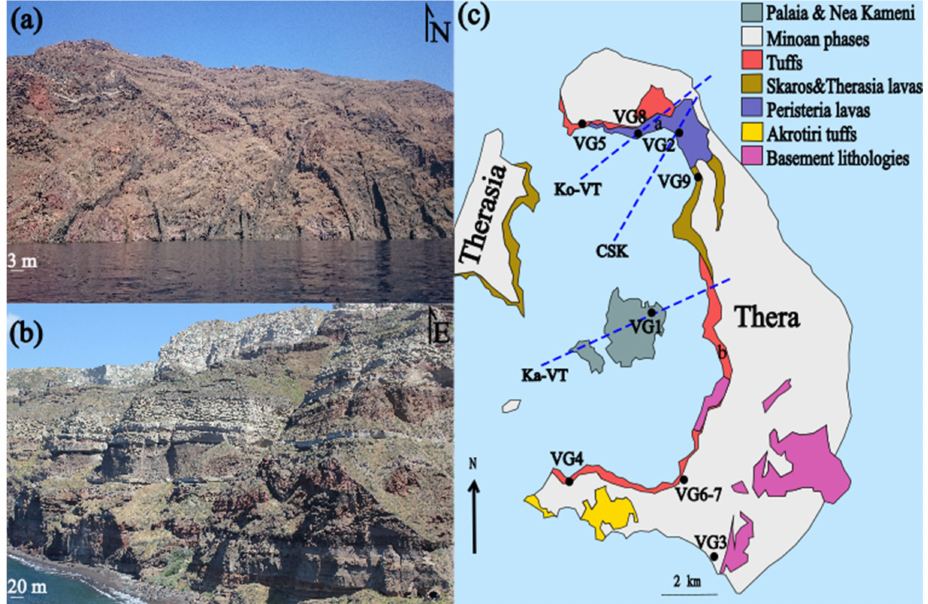
Figure 1. ( a ) Panorama of the northern caldera wall dike swarm showing the heterogeneous and anisotropic crustal segment composed of lava flows and pyroclastic materials. The latter are dissected by 91 dike segments. ( b ) View of Athinios Port with details of the pyroclastic successions derived from the two main eruptive phases, the Minoan and middle pumice layers, which formed the characteristic landforms and erosional surfaces; caldera walls are ~400 m high and extend underneath the water level, to a depth of 390 m (photo courtesy: Agust Gudmundsson). ( c ) Simplified geological map of Santorini (modified from [43]) showing the stratigraphy, main volcano–tectonic lineaments, and location of the virtual geosites (VG1–VG9) presented here. Ko-VT: Kolumbo volcanotectonic